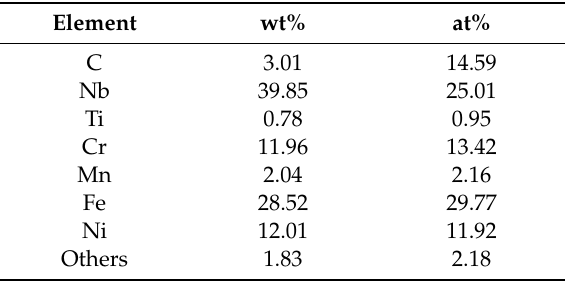
Table 5. Chemical composition of point B by